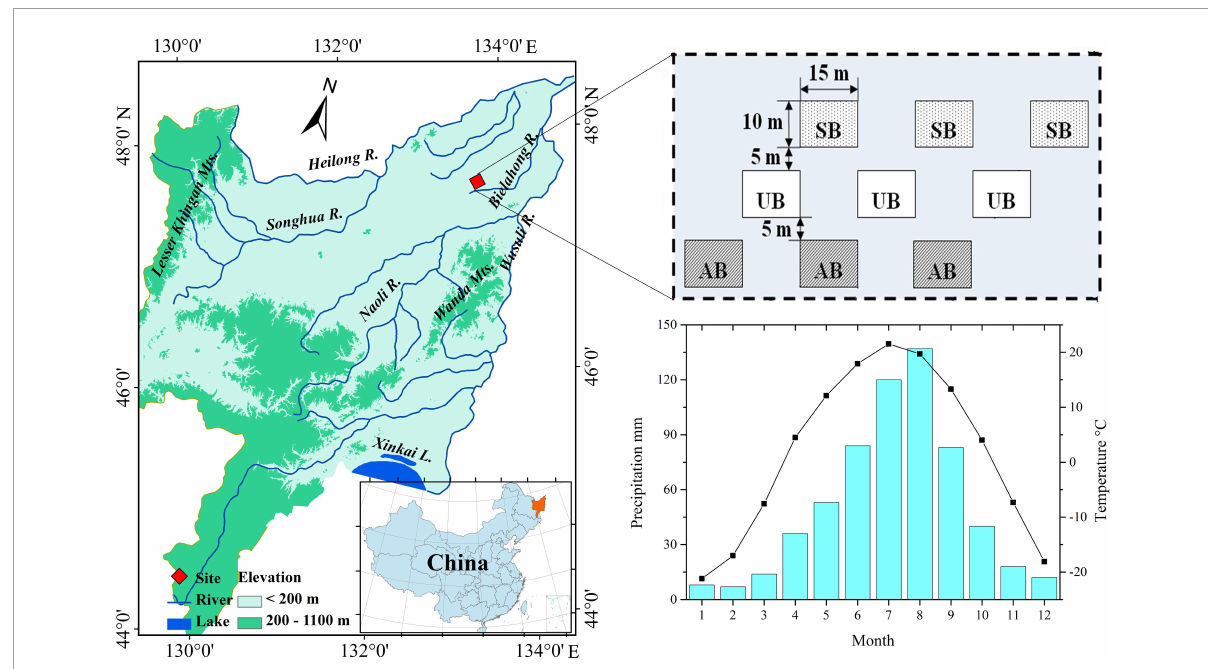
FIGURE1 Location of the studied sites (i.e. spring burnt sites, SB; autumn burnt sites, AB; unburnt sites, UB) in Sanjiang Plain, Northeast China (Gao et al., 2021), and the average monthly temperature and precipitation in Sanjiang Plain (Fick and Hijmans,